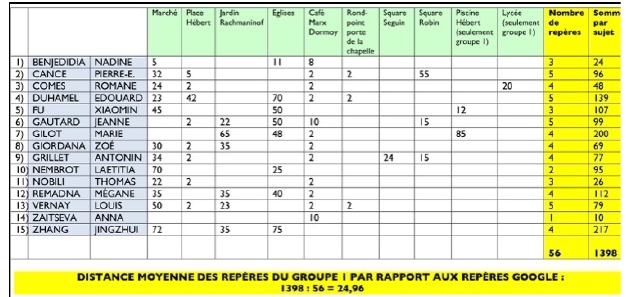
Figure 13. Average distance between landmarks in Google map and landmarks drawn by subjects : Example of results for group 1